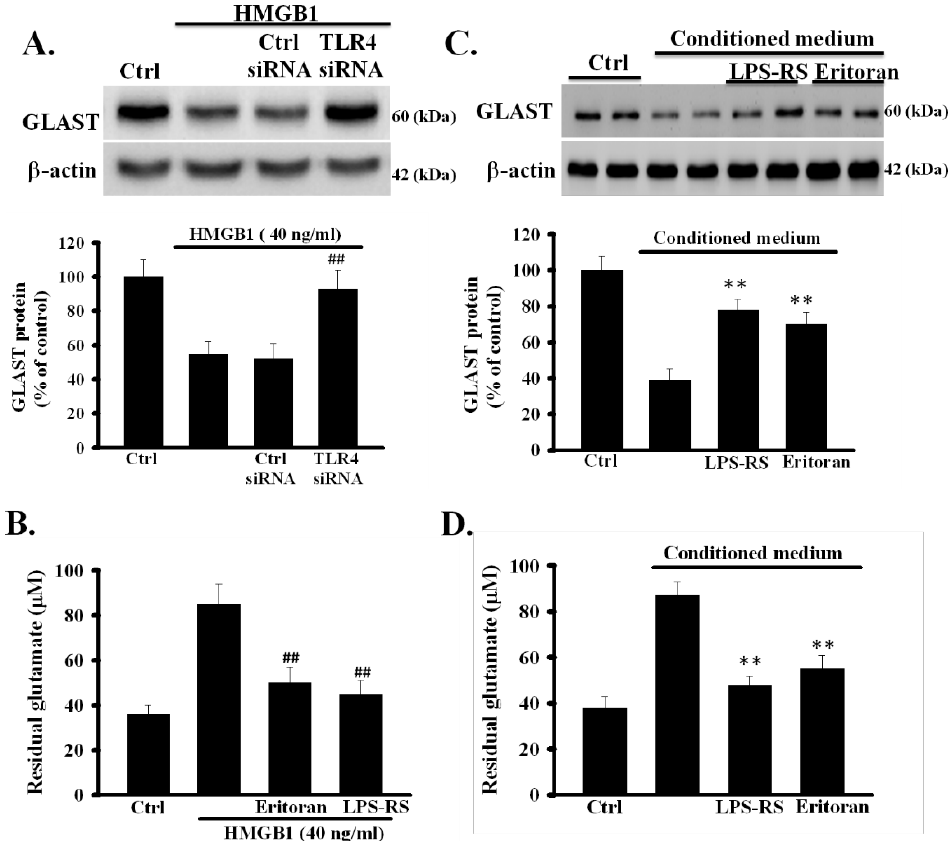
Figure 4. Role of TLR4 on HMGB1 and CM-impaired function of glutamate clearance in primary astrocytes. ( A ) E ff ects of TLR4 knockdown on rHMGB1-reduced expression of GLAST. TLR4 and control siRNA-treated astrocytes were exposed to rHMGB1 (40 ng / mL) for 24 h and the expression levels of GLAST were examined using Western blot. ( B ) E ff ects of TLR4 inhibitors on rHMGB1-inhibited activity of astrocytic glutamate clearance. Primary astrocytes were exposed to rHMGB1 (40 ng / mL) with or without TLR4 inhibitors, eritoran or LPS-RS, and the activity of glutamate clearance was assayed 24 h later. ( C ) Primary astrocytes were exposed to CM with or without TLR4 inhibitors, eritoran or LPS-RS, for 24 h. Thereafter, the expression levels of GLAST protein were examined using Western blot. ( D ) Activity of astrocytic glutamate clearance was assayed by measuring the residual glutamate in CM. ## p < 0.01 vs. rHMGB1 alone, ** p < 0.01 vs. CM alone. Data are presented as mean ± SEM, n = 6. OGD / R, oxygen-glucose deprivation / reoxygenation; HMGB1, high-mobility group box 1; rHMGB1, recombinant HMGB1; CM, conditioned medium; TLR4, toll-like receptor 4; GLAST, glutamate aspartate transporter; n , number of repeated examinations; LPS-RS, lipopolysaccharide from Rhodobacter